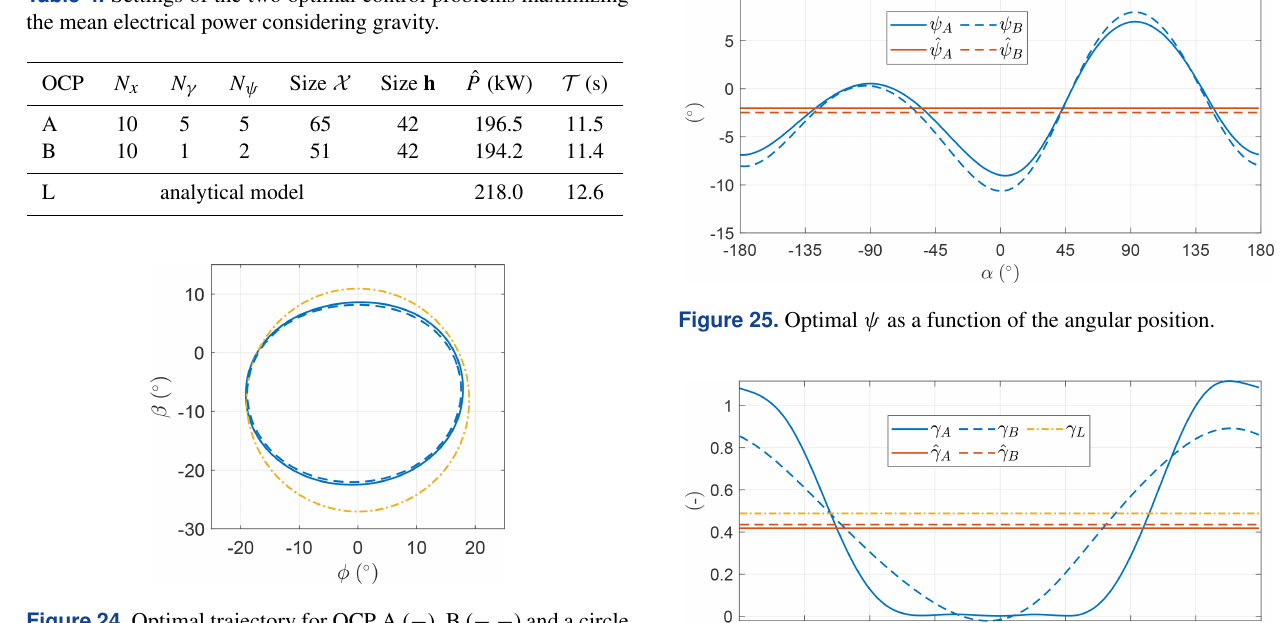
Figure 24. Optimal trajectory for OCP A ( − ), B ( − − ) and a circle with radius ˜ (cid:56) ( − . ).